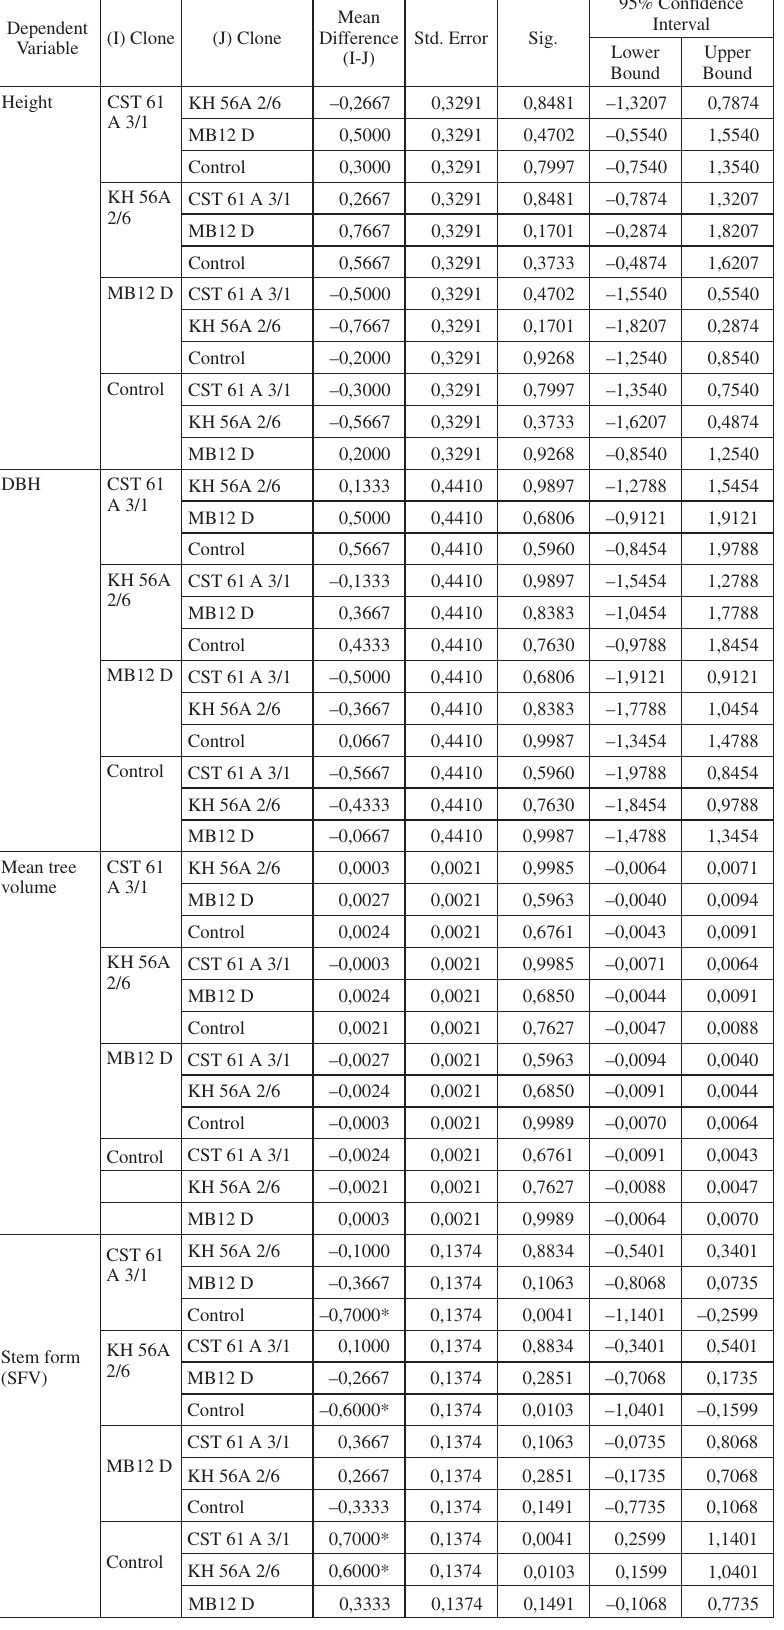
Table 2: Results of Tukey’s HSD test of the micropropagated black locust clones’ stand characteristics Dependent